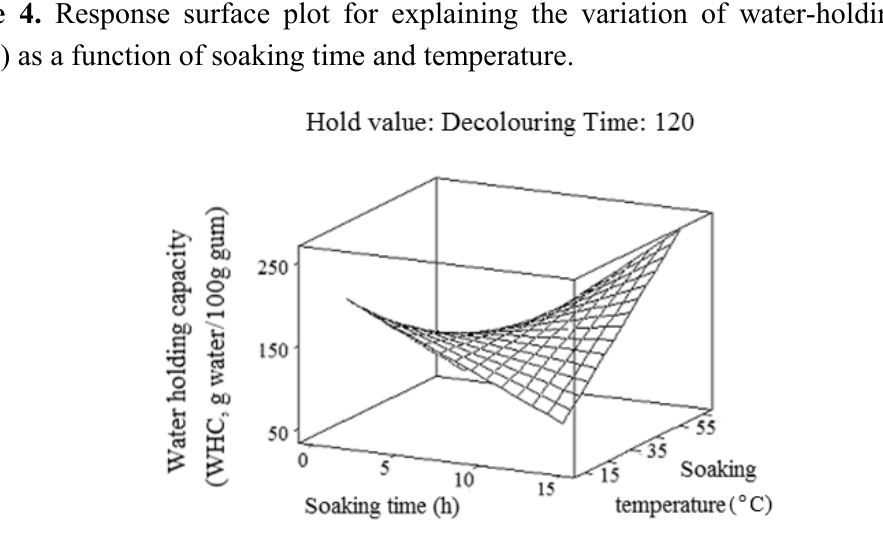
Figure 4. Response surface plot for explaining the variation of water-holding capacity (WHC) as a function of soaking time and